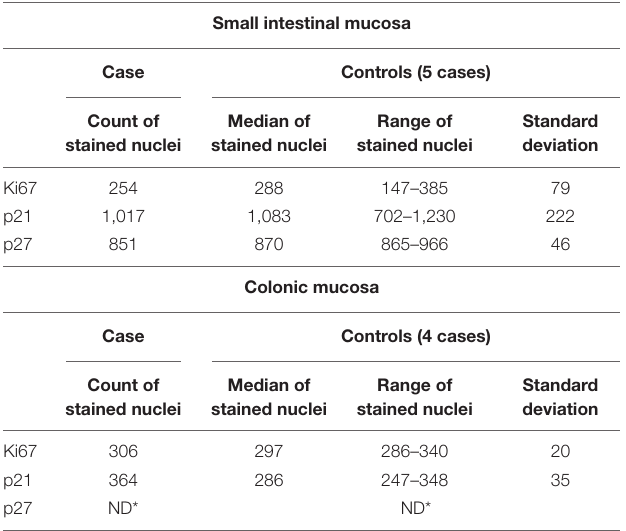
TABLE 1 | Results of the counts on epithelial cells immunostained with Ki67 Mib-1, p21, and p27 with an image analysis software (see text) in small intestinal and colonic sampling, in our case and